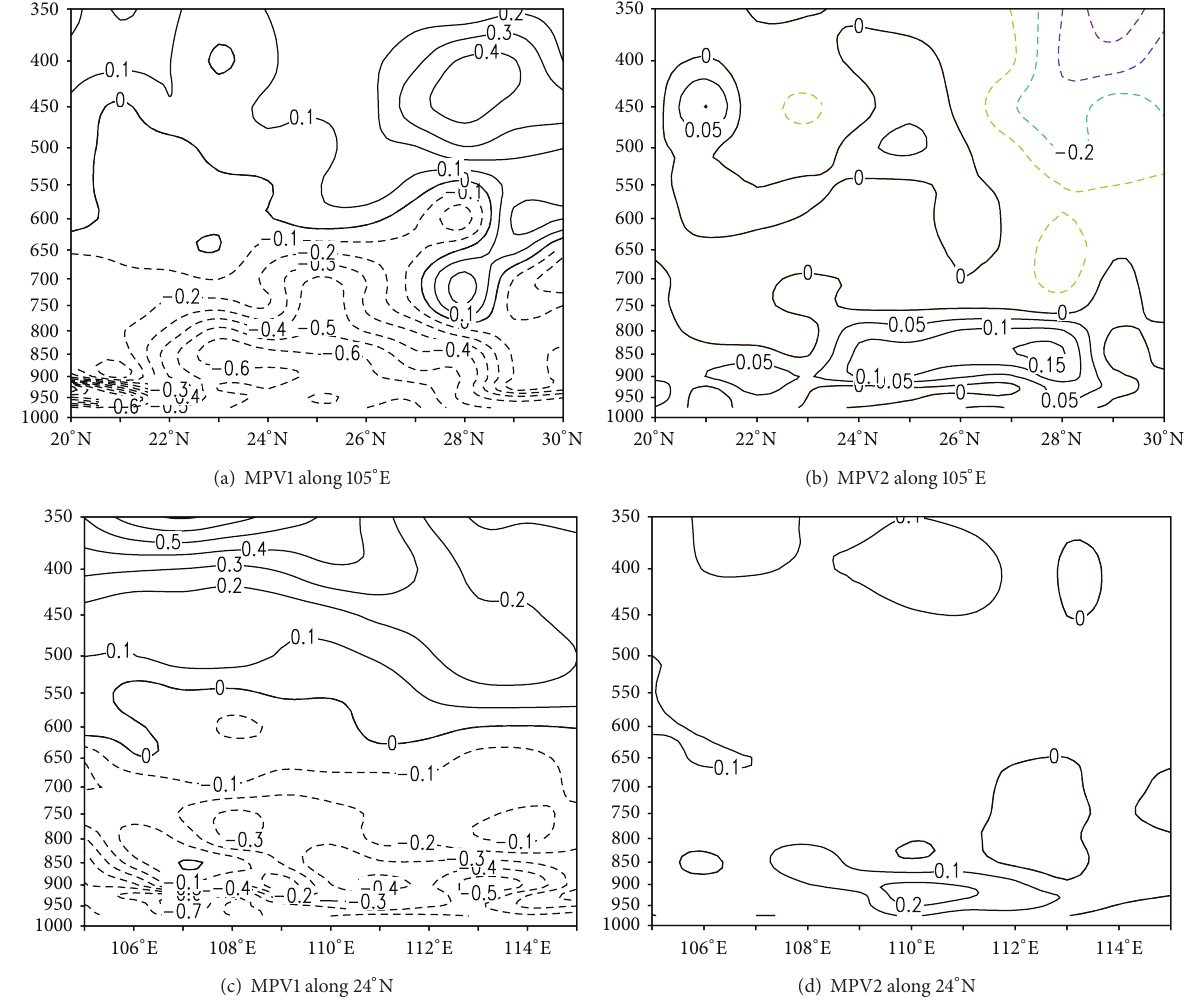
Figure 8: The time-mean MPV1 and MPV2 profiles for (a, b) phases I and (c, d) II. Their unit in PVU (1PVU = 10 −6 m 2 ⋅ K ⋅ s −1 ⋅ kg −1